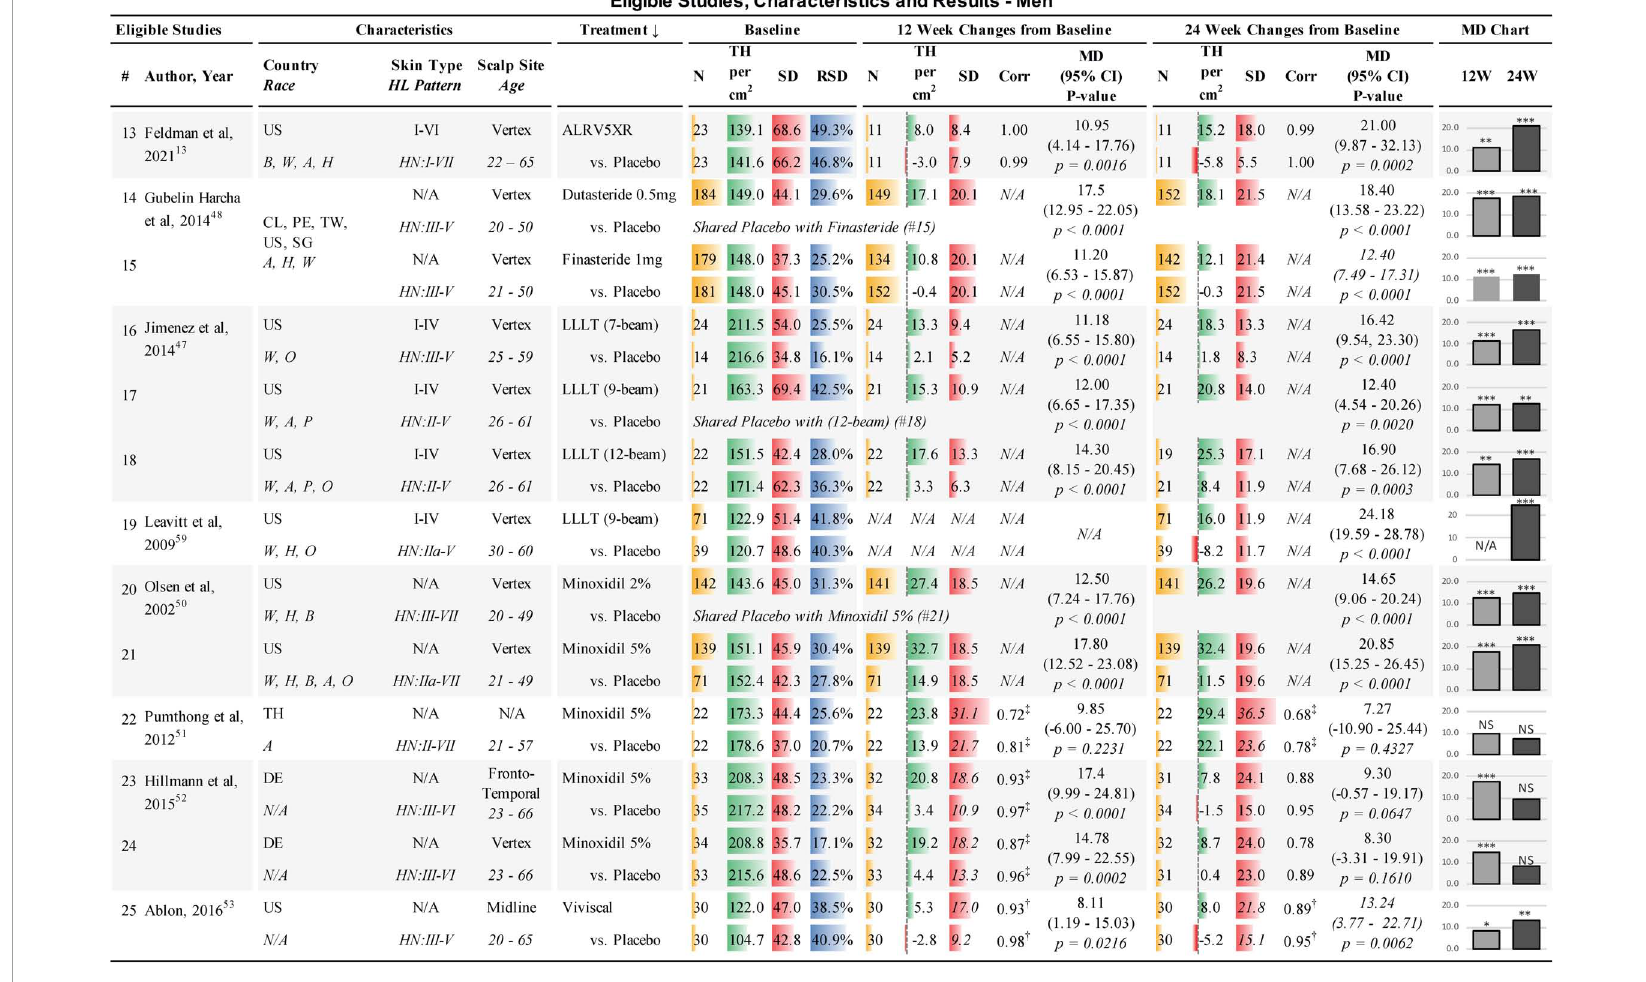
FIGURE2 Eligible studies, characteristics, and results — Men. ↓ , primary sort by treatment (secondary by year of study); Country: US, United States of America; CL, Chile; PE, Peru; TW, Taiwan; SG, Singapore; DE, Germany; Race: W, White; H, Hawaiian; A, Asian; B, African; P, Pacific; O, other; Skin Type, Fitzpatrick I-VI; HL, hair loss pattern (Hamilton-Norwood scale); Scalp Site is observed position in study; Age, study-cohort age range; N, sample population in each arm; TH, terminal hair (mean count per cm 2 ); SD, standard deviation; RSD, relative SD (SD/TH); Corr, correlation factor; ‡ , derived from 6-month endpoint Corr; † , derived from average Corr; MD, mean difference between treatment and Placebo; 95% CI = 95% confidence interval; 12W and 24W, 12 and 24 weeks of treatment; bar chart colors for N, TH, SD, ratio, and MD chart are for illustrative purposes; N/A, not available; NS, not statistically significant; ∗ , ∗∗ , and ∗∗∗ are frequentist statistically significant P -values < 0.05, < 0.01, and < 0.001, respectively. Details from studies 14 and 15 (48) were clarified from Clinicaltrials.gov: